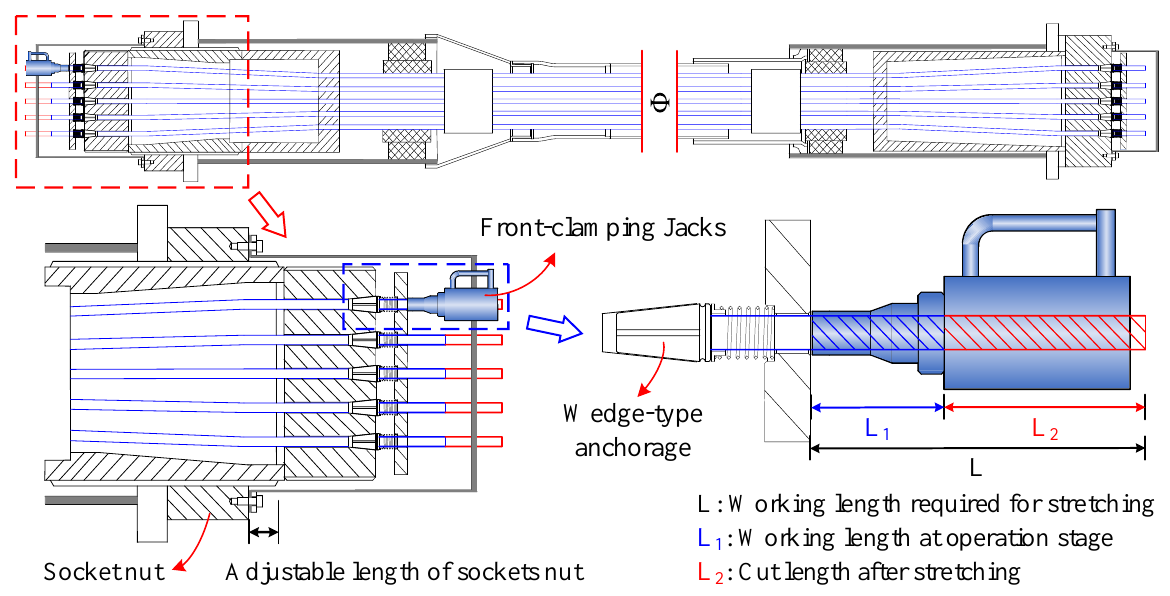
Figure 2. Adjustable length of the parallel strand cable.